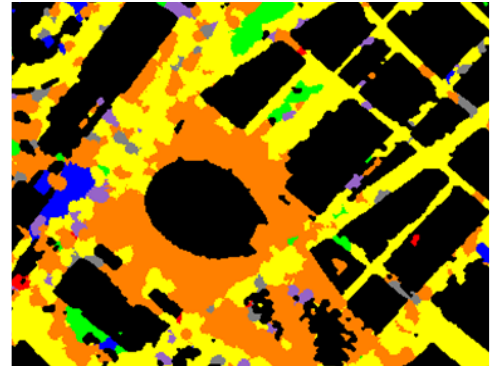
Figure 5. Light source type map derived from hyperspectral sensor.